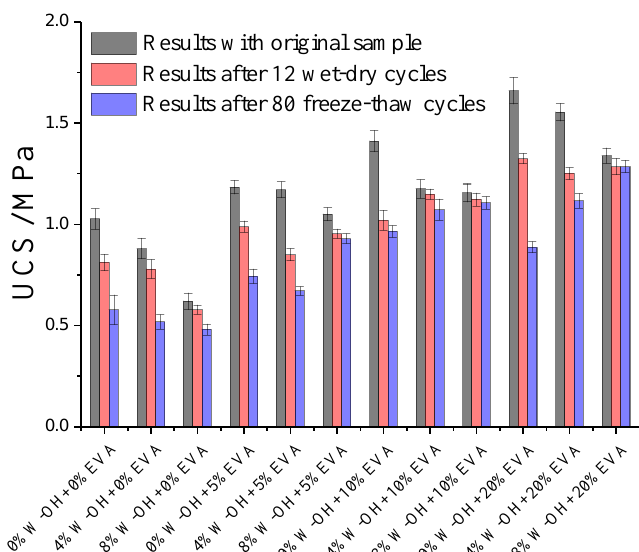
Figure 10. Strength of the Induration prepared with EVA modified polyurethane and remolded Pisha sandstone (0%W-OH, 4%W-OH, and 8%W-OH represent the Original, R-P-1 and R-P-5 type aggregates respectively; 0% EVA, 5% EVA, 10% EVA and 20% EVA represent the Original, 5% EVA, 10% EVA and 20% EVA modified W-OH Polyurethane were applied to re-solidify the remolded Pisha sandstone).